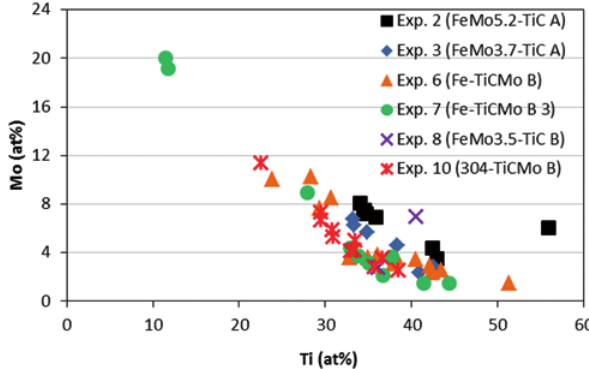
Fig. 16: Molybdenum and Titanium contents in TiC particles containing